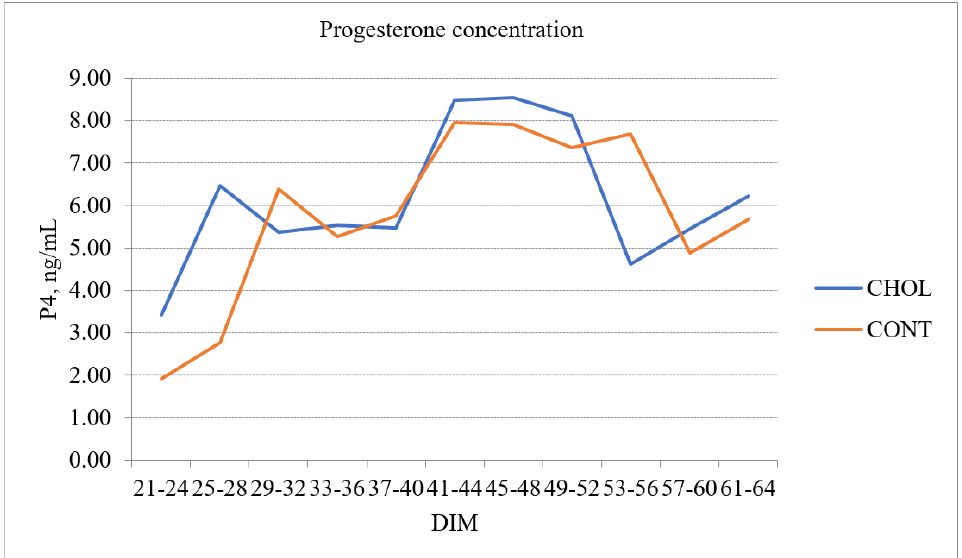
Figure 2. Changes in progesterone concentration in milk of the choline and control groups at differ- ent DIM intervals.